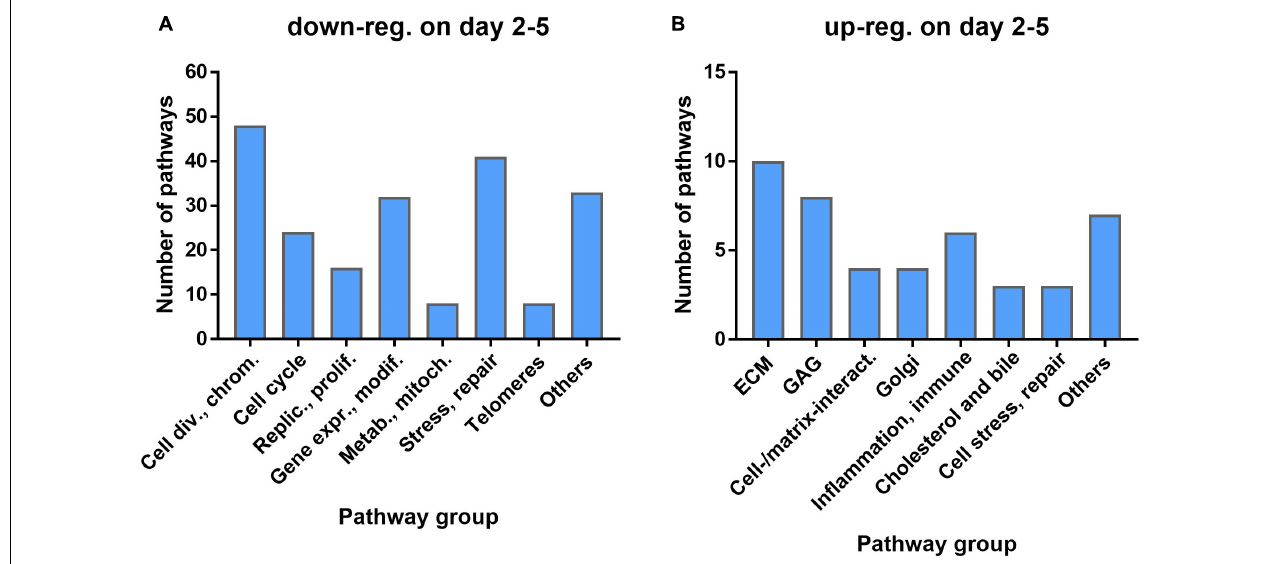
FIGURE 3 | Number of pathways by functional group for pathways commonly down-regulated (A) or up-regulated (B) at all three time